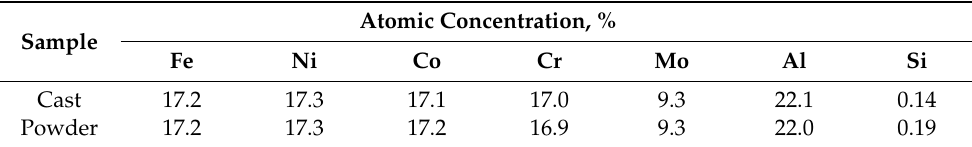
Table 1. Chemical composition of the cast sample and the gas atomized powder.